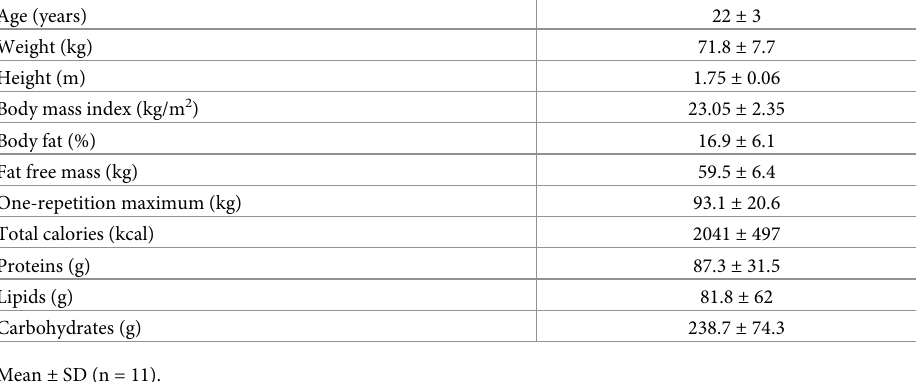
Table 1. Participants’ baseline characteristics and dietary